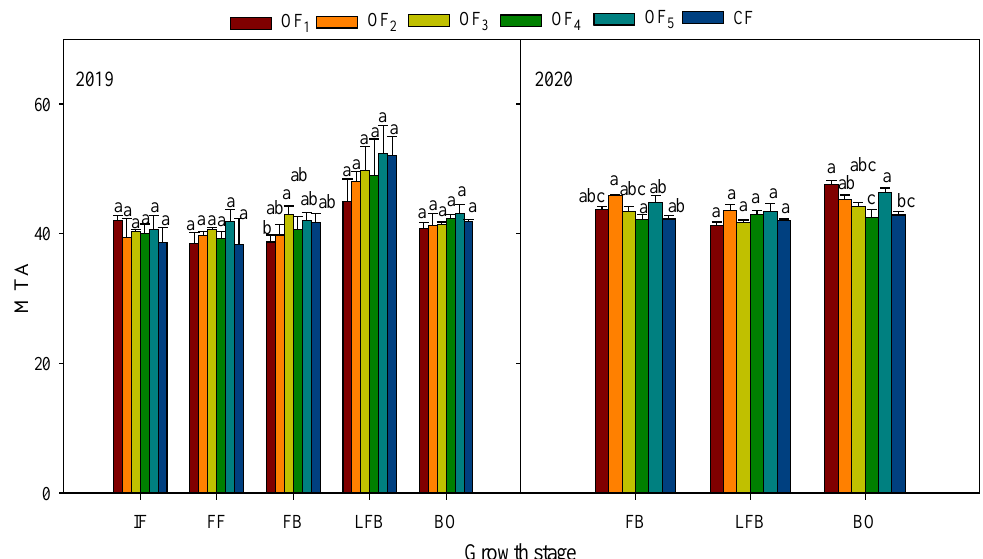
Figure 5. Effect of organic liquid fertilizer combined with different ratios of chemical fertilizers on cotton leaf inclination. IF, initial flowering stage; FF, full-flowering stage; FB, full-boll stage; LFB, late full-boll stage; BO, boll-opening stage. Different letters above the columns indicate statistical significance at the p = 0.05 level within the same growth stage in each year.